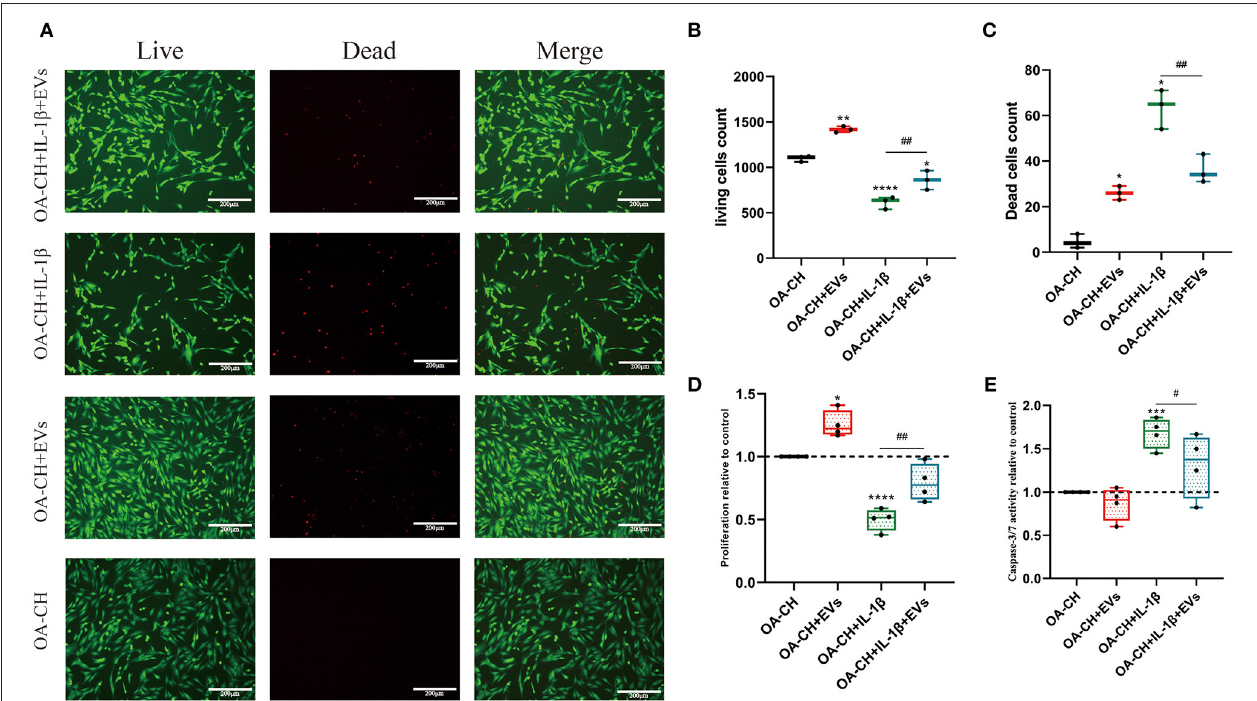
FIGURE 5 | Effect of hBMSC-EVs on vitality, proliferation, and apoptosis of OA-CH and IL-1 β -induced OA-CH. (A–C) Live and dead cells were visualized by fluorescence microscopy after labeling cells with calcein and ethidium homodimer. Living cells were labeled with calcein (green fluorescence) and dead cells were stained with ethidium homodimer (red fluorescence). Scale bar = 200 µ m. (D,E) BrdU incorporation assay and Caspase-3/7 activity assay were used to determine the proliferation and apoptosis rate of OA-CH after treatment with hBMSC-EVs or IL-1 β for 24h. The OA-CH group without treatment is used as control and set to 1.0 (black bars). *Significant difference to control (OA-CH): * p < 0.05; ** p < 0.01; *** p < 0.001; **** p < 0.001; # significant difference between groups: # p < 0.05; ## p < 0.01; one-way ANOVA with Newman–Keuls Multiple Comparison Test; n =